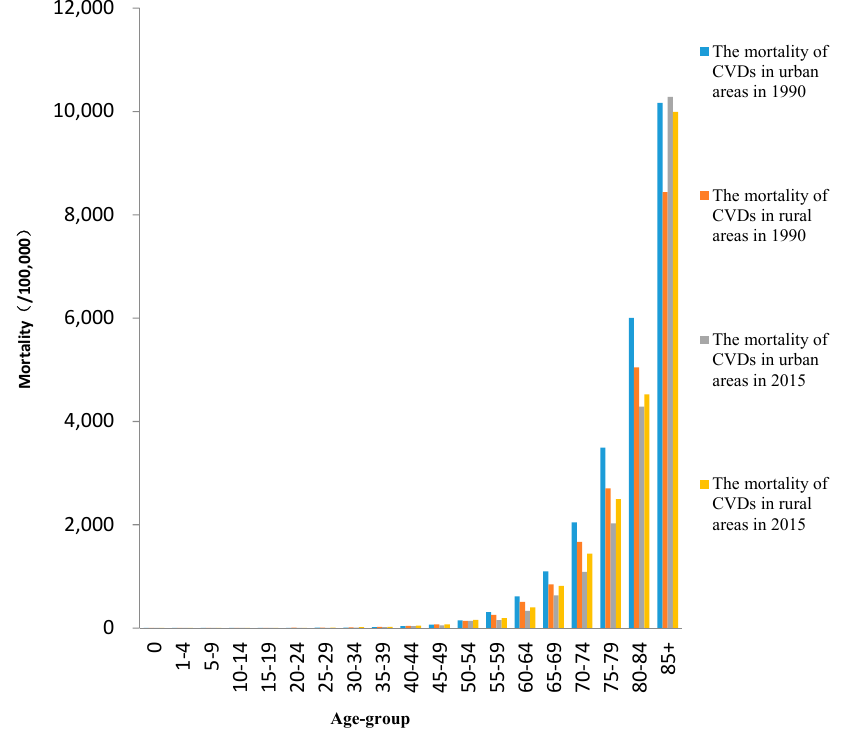
Int. J. Environ. Res. Public Health 2017 , 14 , 1391